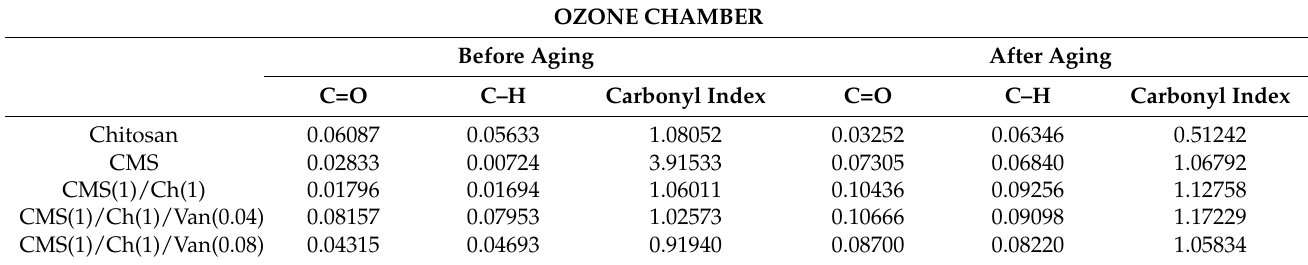
Table 7. Detailed analysis of the CI determination for modular